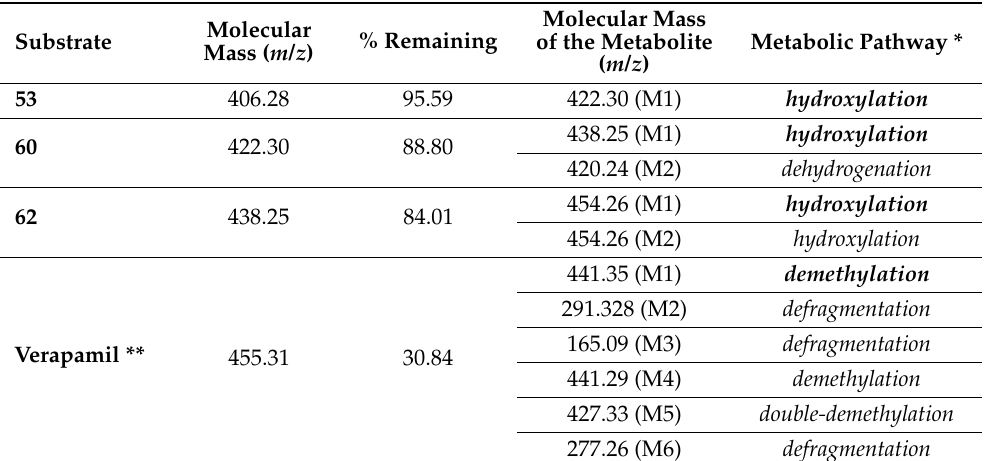
Table 7. Metabolic stability/biotransformation pathways after incubation with